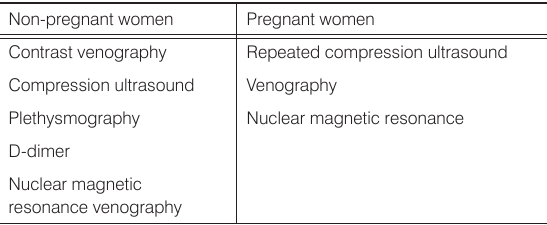
Table 1. Risk factors for thromboembolism in pregnancy. Table 2. Paraclinic investigations for diagnosis of deep vein throm- bosis in non-pregnant and pregnant